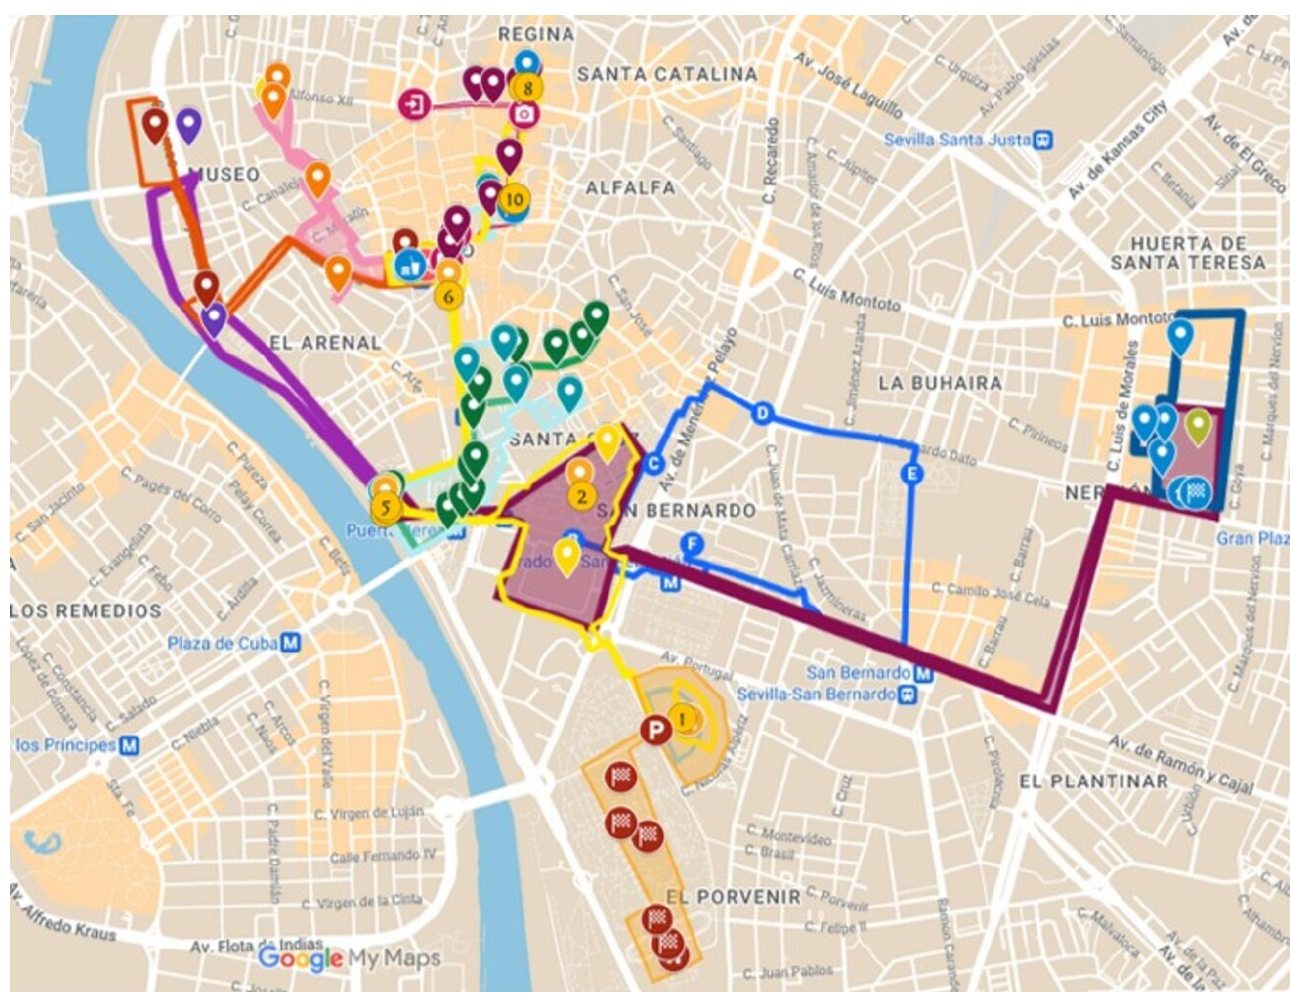
Figure 1. Interactive map of Seville with all the Math Trails developed by the students. The lines with different colors represent the itineraries and the markers are the stops of the Math Trails. Available at: https://bit.ly/3IT25ZT (accessed on 19 July 2022).